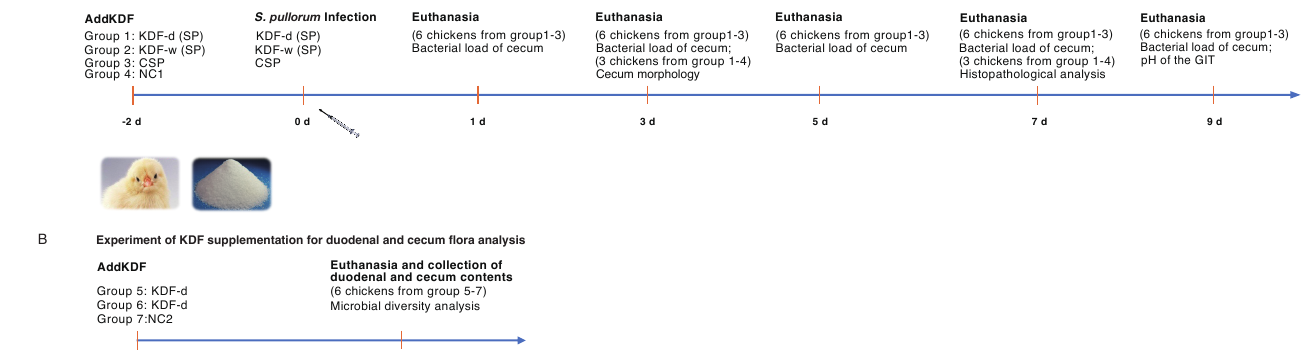
Figure 1. Animal experiment protocol. ( A ) Animal infection experiment protocol. KDF-d (SP): chickens supplied with 0.5% KDF in diet infected with S. pullorum (n = 30); KDF-w (SP): chickens supplied with 0.1% KDF in drinking water infected with S. pullorum (n = 30); CSP: chickens supplied with non-supplemented diet and water infected with S. pullorum (n = 30); NC1: chickens supplied with non-supplemented diet and water without infection (n = 10). ( B ) KDF supplementation experiment protocol for duodenal and cecum flora analysis. KDF-d: chickens supplied with 0.5% KDF in diet without infection (n = 6); KDF-w: chickens supplied with 0.1% KDF in drinking water without infection (n = 6); NC2: chickens supplied with non-supplemented diet and water without infection (n =